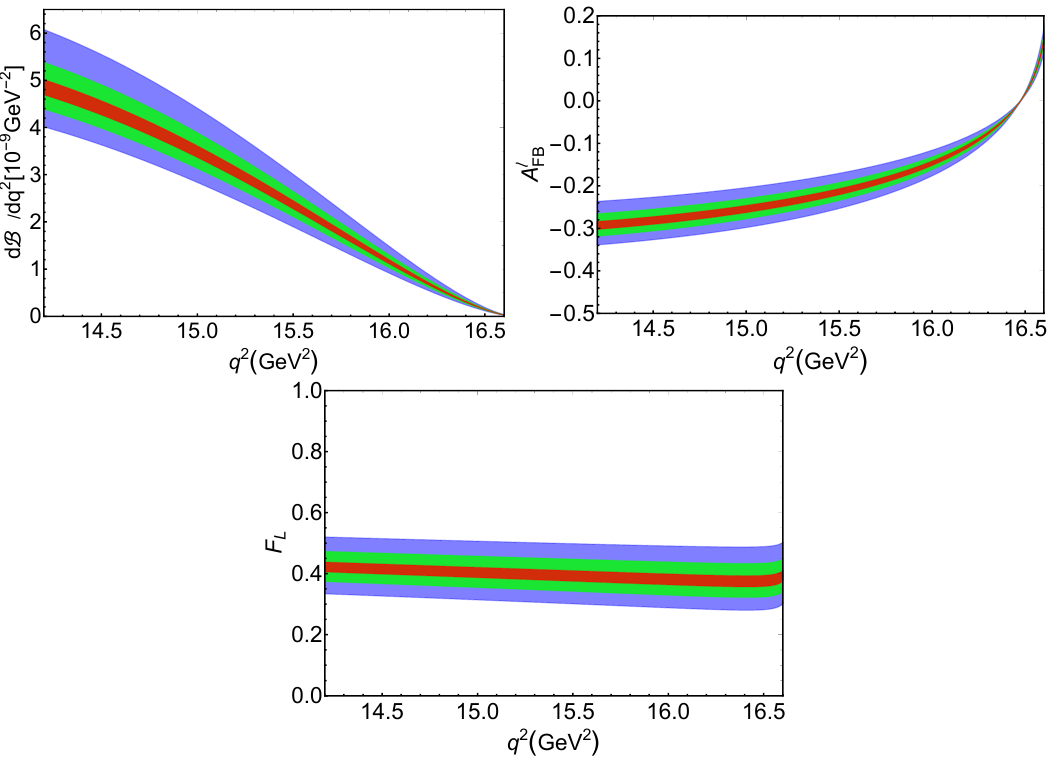
Figure 1 . The di(cid:11)erential branching ratio, lepton-side forward-backward asymmetry, and the longitudinal polarization fraction of (cid:3) b ! (cid:3) (cid:3) ( ! N (cid:22) K ) (cid:22) + (cid:22) (cid:0) in the SM at the low-recoil. The blue, green, and red bands correspond to the uncertainties coming from the form factors, corrections to the Isgur-Wise relations, and sub-leading corrections to the amplitudes. The (cid:12)gures are for illustrative purpose only (see text for